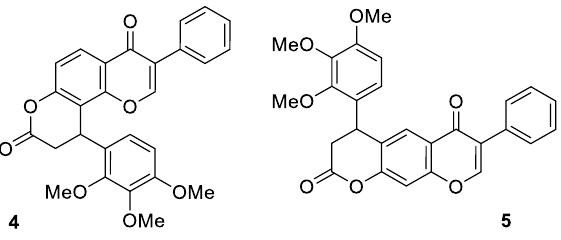
Figure 2. Two isomeric products 4 and 5